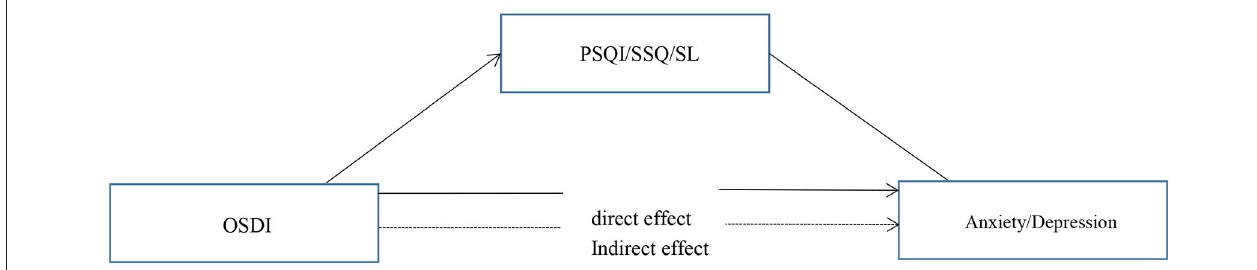
FIGURE 1 | The proposed model of relationships between variables.